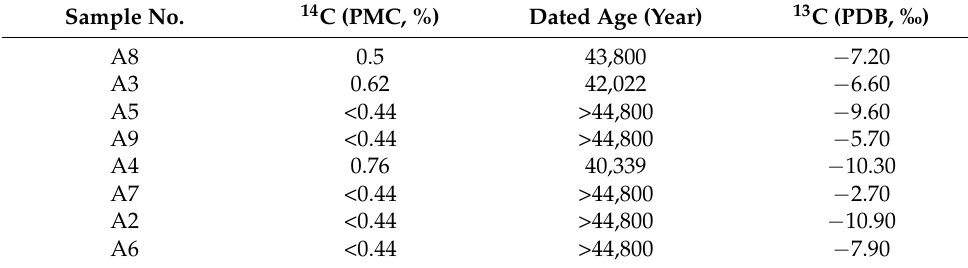
Table 3. Results of geothermal water carbon isotope testing in the area. Sample No.